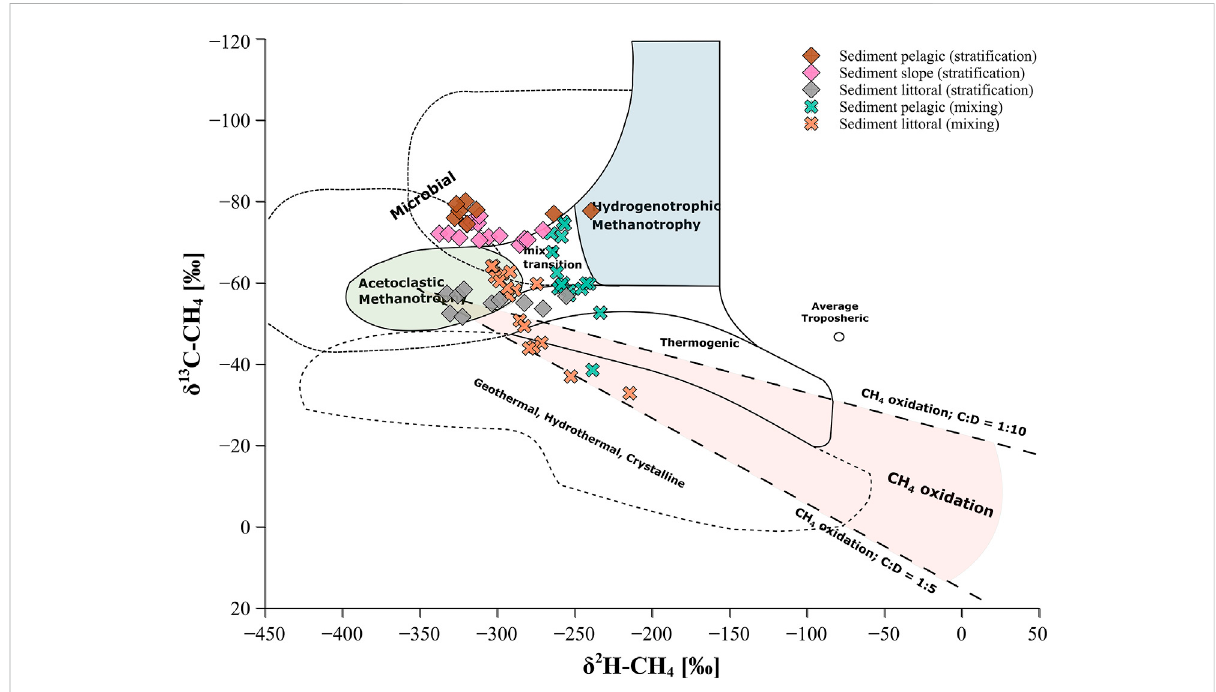
FIGURE 6 2-dimensional isotope plot of sedimentary CH 4 data from the strati fi cation and mixing period implemented into the classi fi cation of methanogenic pathways modi fi ed after (Whiticar, (2020). The dotted lines represent the range of ratios of 13 C and 2 H (C:D) enrichment during anaerobic CH 4 oxidation as reported by Martens et al. (1999), Holler et al. (2009) and Rasigraf et al.